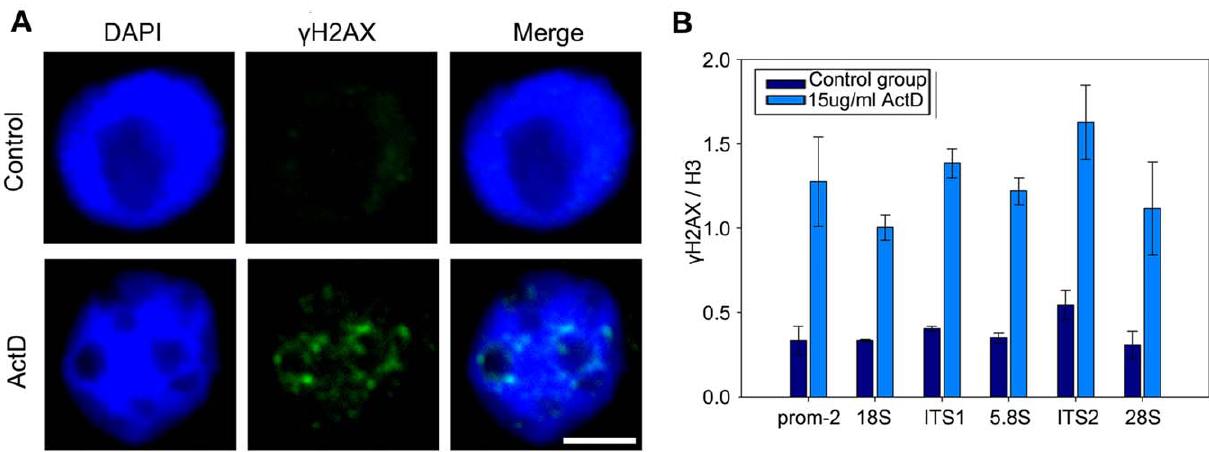
Figure 7. ActD treatment accumulates c H2AX within 45S rDNA regions in maize.. (A) Indirect immunofluorescence staining with an antibody against c H2AX showed weak staining signals surrounded the nucleolus without treatment but intense staining signals surrounded fragmented nucleoli after treatment with 15 m g/ml ActD. Bar=10 m m. (B) ChIP analysis of c H2AX levels within 45S rDNA regions in maize treated without or with 15 m g/ml ActD. DNA associated with c H2AX was immunoprecipitated with the anti- c H2AX antibody and primers specific for different regions of 45S rDNA were used to amplify DNA for quantitative real-time PCR. The y-axis values were the relative quantities of c H2AX levels relative to total H3 at each amplicon and the x-axis indicated different regions of 45S rDNA. Each experiment was repeated three times and the average value was shown with the SD.